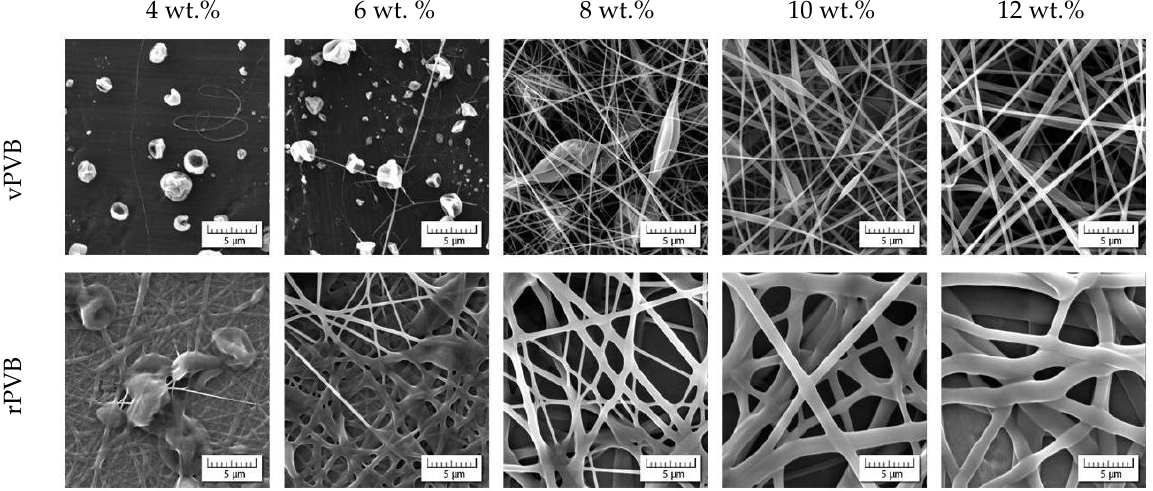
Figure 5. Morphology of nanofibrous webs of recycled and virgin PVB (various concentrations in ethanol).